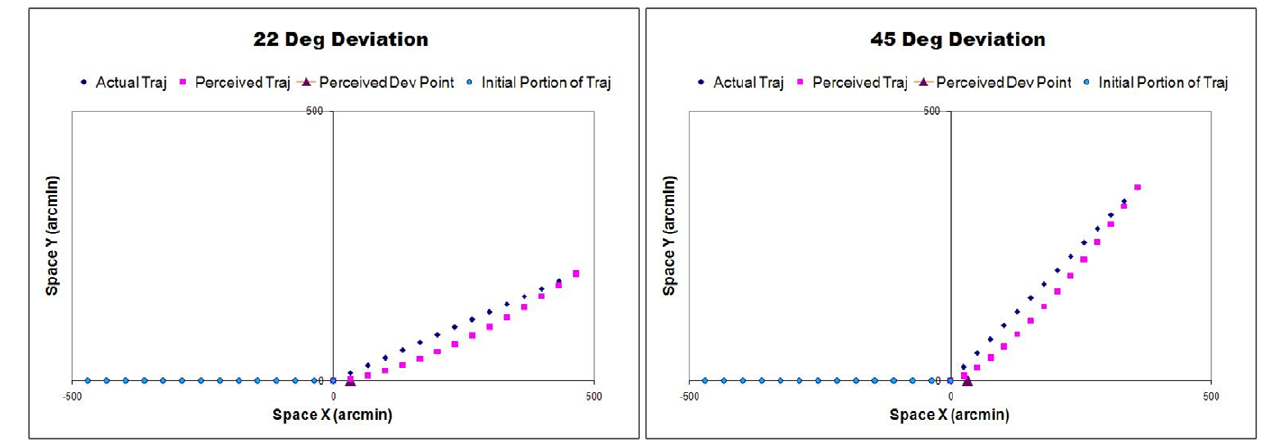
Figure 5. The actual trajectories, perceived trajectories and the perceived points of deviation obtained for observer MA for two of the deviation angles. The axes are in arcmin and the actual trajectories shown are scaled representations of the real stimulus.